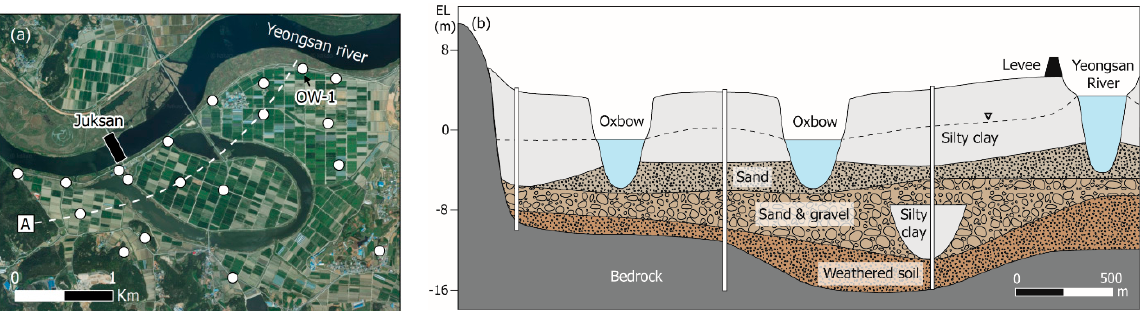
Figure 2. ( a ) Locations of the monitoring wells and ( b ) sedimentary units in the alluvial deposits along transect A.